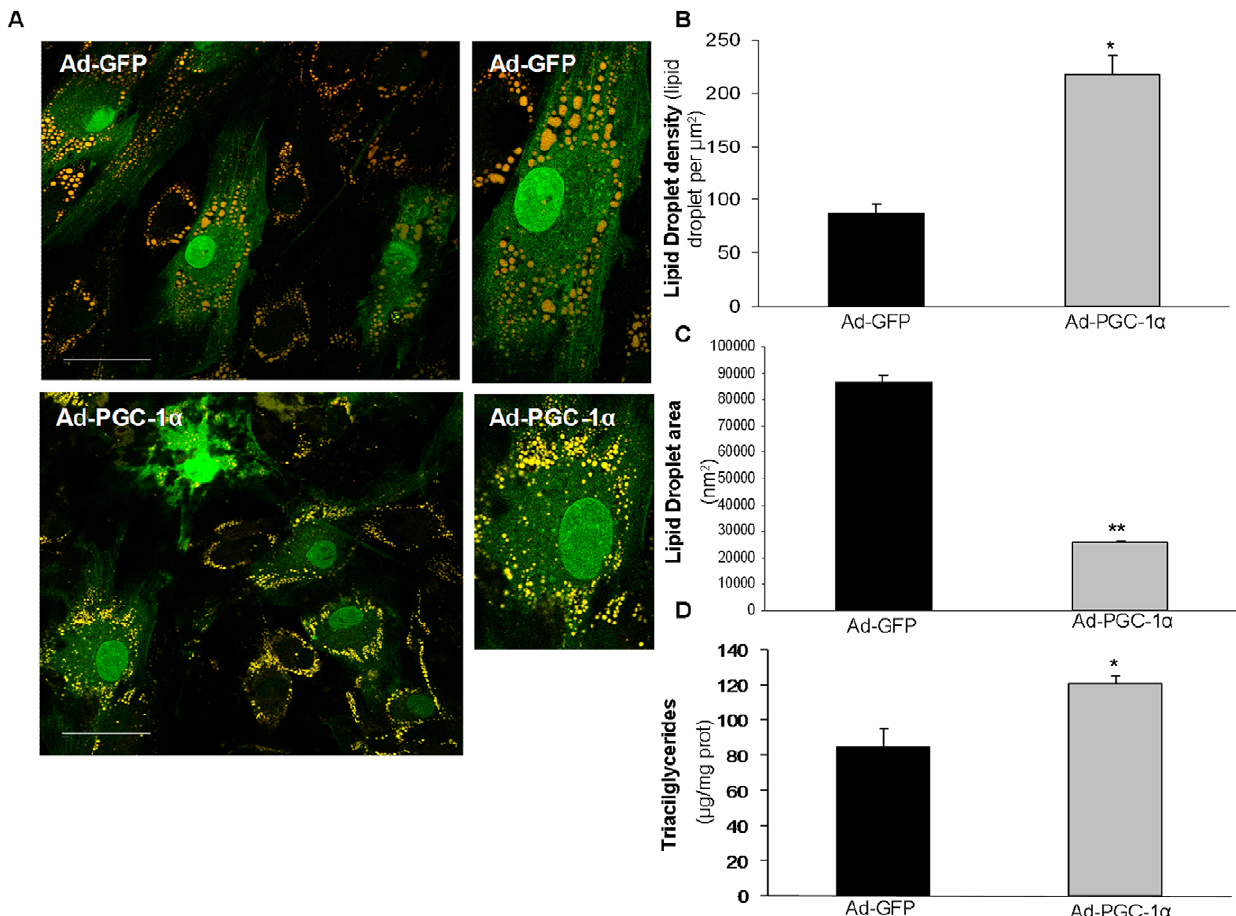
Figure 5. Effect of PGC-1 a -overexpression on lipid droplets and triglyceride accumulation in cultured muscle cells. Cultured skm cells were transduced with Ad-GFP or Ad-PGC-1 a and incubated with 0.5 mM oleate for 16 h. (A,B,C) Cells were fixed and then stained with Nile Red. (A) Representative lipid droplet micrographs obtained via confocal microscopy are shown. White bars represent 5 m m. (B) The number of lipid droplets per cell area and (C) the lipid droplet mean area values were quantified. Data are means 6 SEM of (B) four cells or (C) at least 414 droplets. (D) Triglyceride content was measured. Data are means 6 SEM of three experiments performed in quadruplicate. (B,C,D) The significance of the differences versus cells treated with Ad-GFP is *p , 0.05 and **p ,